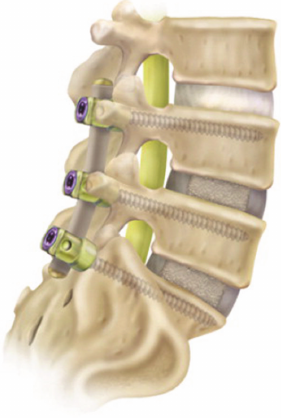
Figure 6: The CD-Horizon Legacy PEEK